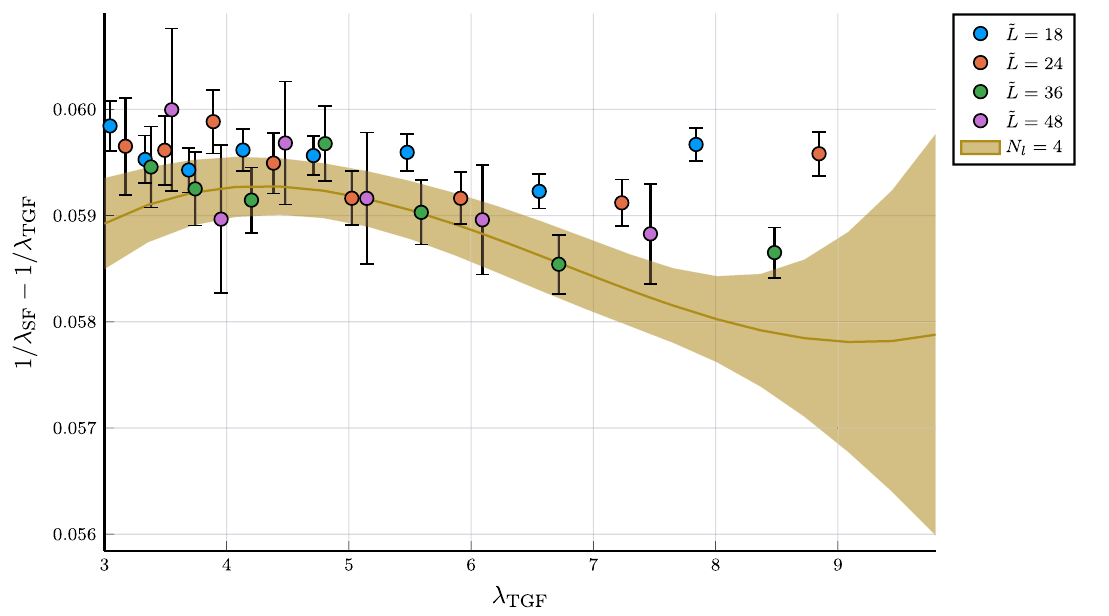
Fig. 11 Non perturbative matching between the SF and the TGF couplings. We use the available data for the SF coupling in [13]. In the fit we discard the data with ˜ L = 18, but these are plotted to show the consistency of the